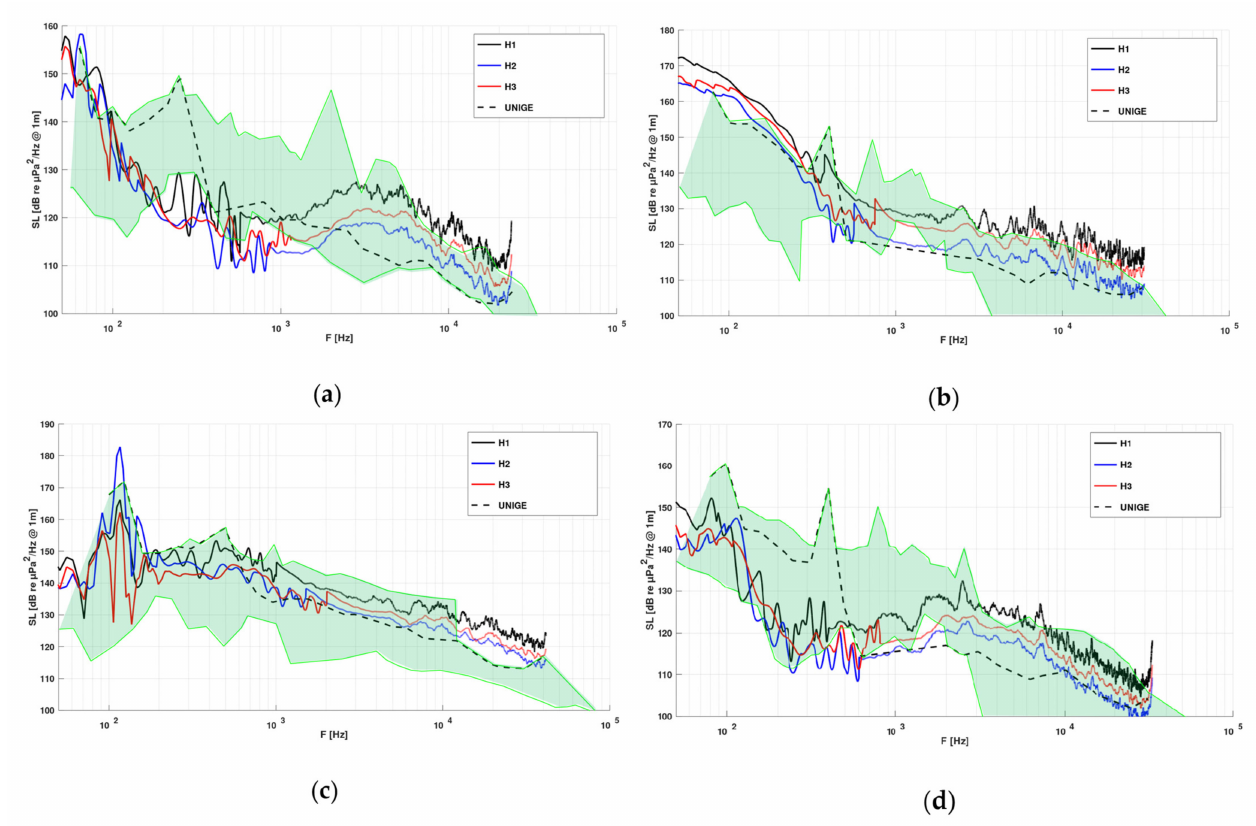
Figure 5. Newcastle. SL for the three pressure observers with measurement for the conditions: ( a ) C1; ( b ) C2; ( c ) C3; ( d )